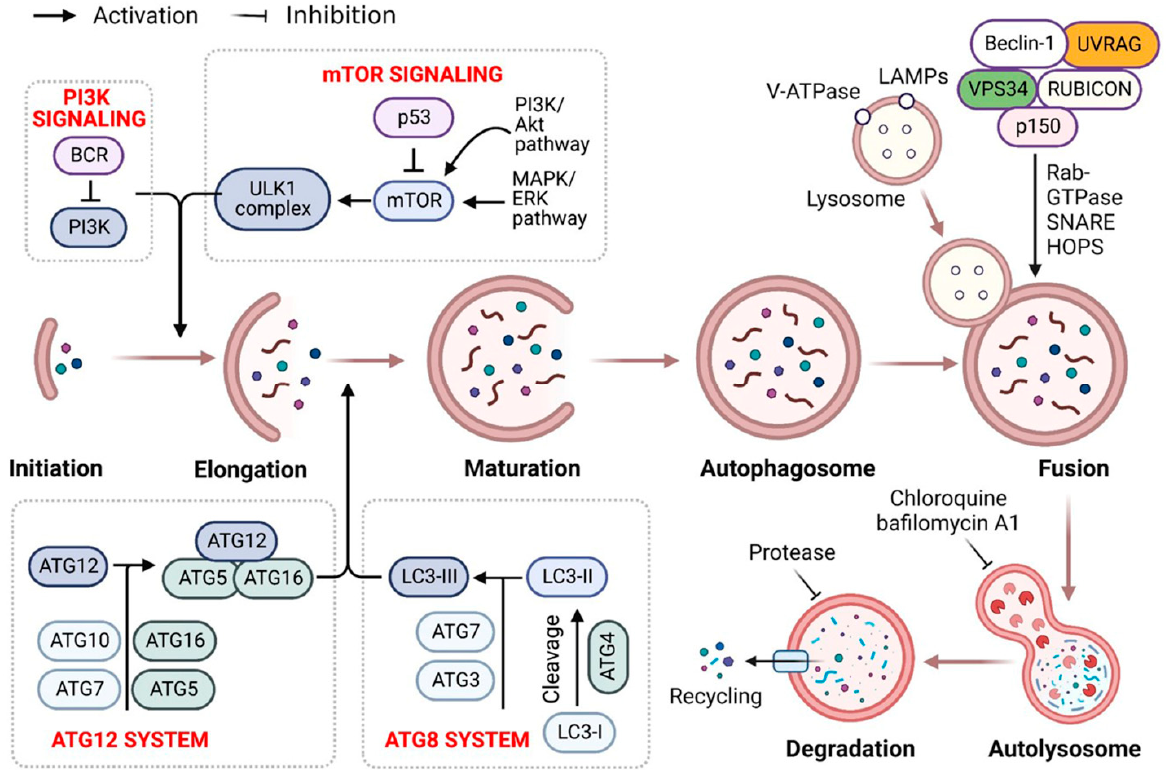
Figure 1. Autophagy signaling at the molecular level. Typically, autophagy is triggered by a shortage of developmental factors or nutrition, which inhibits AMP-activated protein kinase (AMPK) or mTOR. Following Beclin-1 phosphorylation, it activates VPS34, initiating phagophore formation. Conjugation of ATG5-ATG12 includes ATG7 and ATG10, forming an ATG12-ATG5-ATG16 complex that also induces phagophore formation. ATG12 and ATG5 form the ATG16 complex, which serves as an E3 function in the LC3-phosphatidylethanolamine (PE) assembly operation (LC3-II). Similarly, this compound begins phagophore formation. LC3-II is a specific autophagy marker eventually disrupted by autolysosomes. Autophagosome maturation results in its fusion with lysosomes and multiple lysosomal proteins, resulting in cargo destruction and metabolite and nutrient recycling.